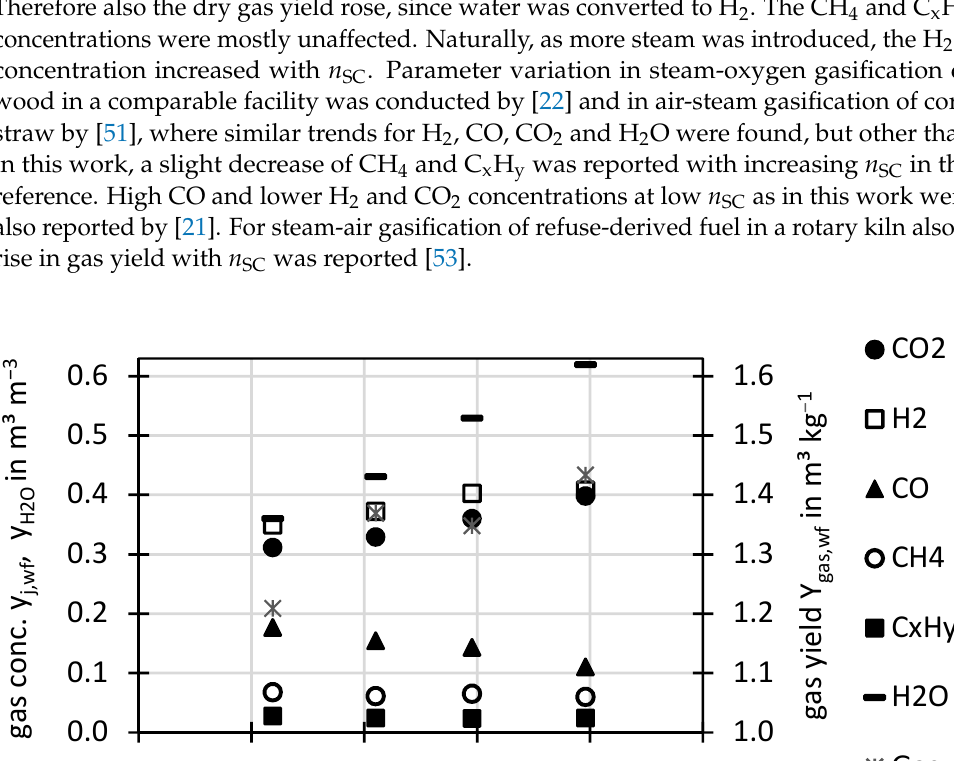
Figure 4: Permanent gas concentrations for different n SC in dry N 2 -free basis, for H 2 O wet N 2 -free 374 basis and dry N 2 -free gas yield per dry ash free